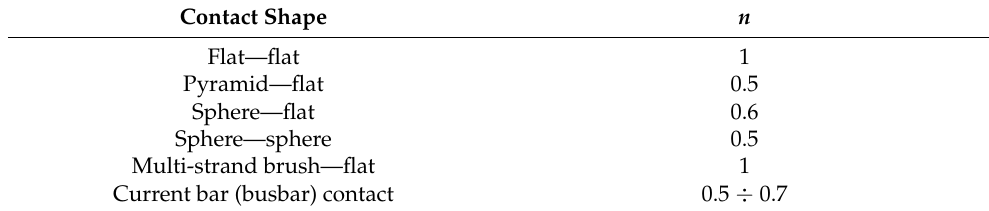
Table 2. Table of shape dependent exponent of the contact force n [19]. Contact Shape